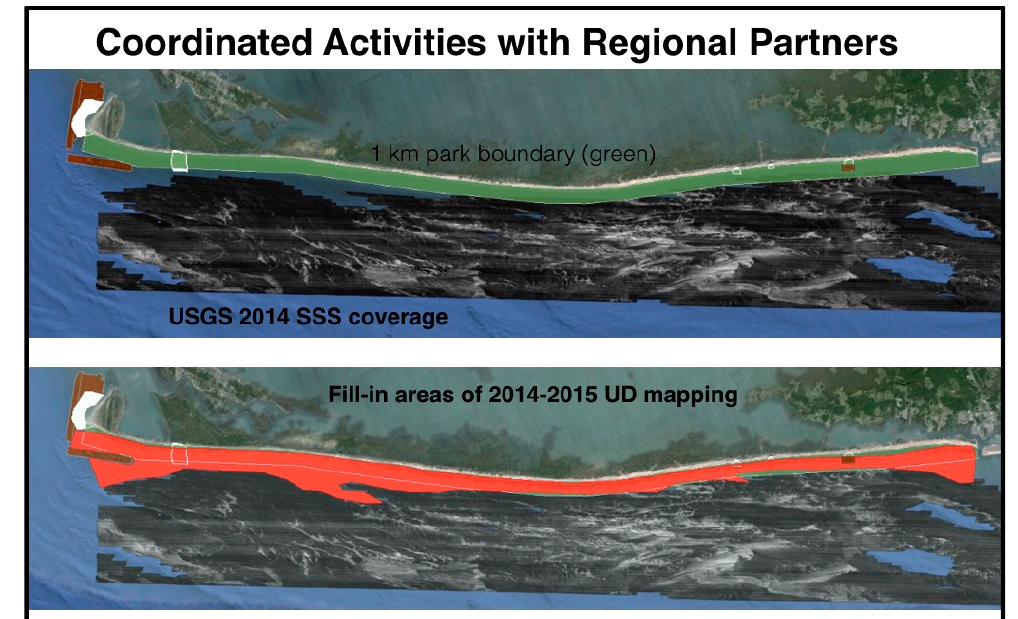
Figure 6. Overview of study site area showing park boundary (green) and recent USGS coverage along with UD mapping team gap filling coverage (red).